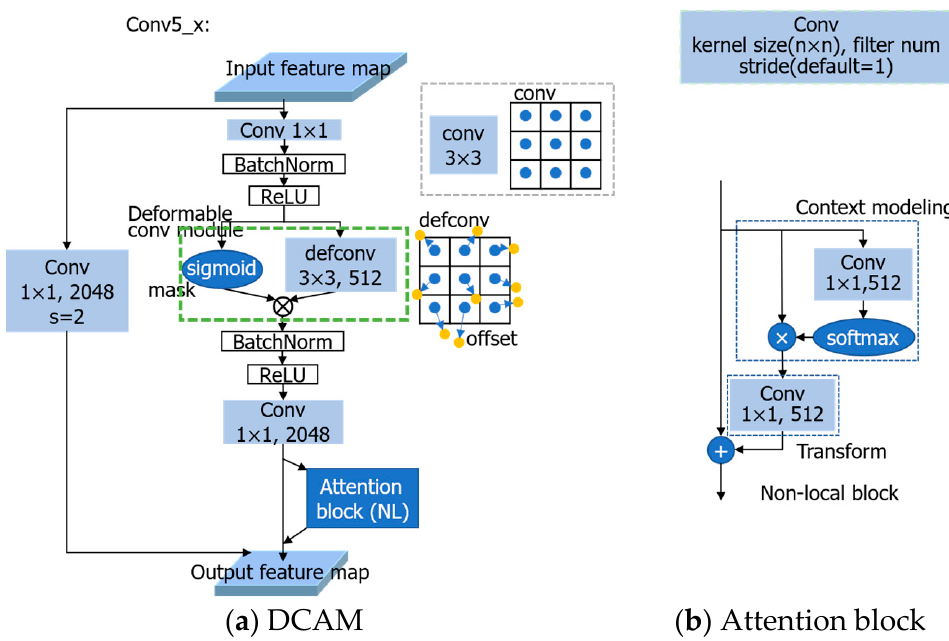
Figure 4. ( a ) The deformable convolution with attention module (DCAM) and ( b ) the non-local (NL) attention block built in the DCAM.